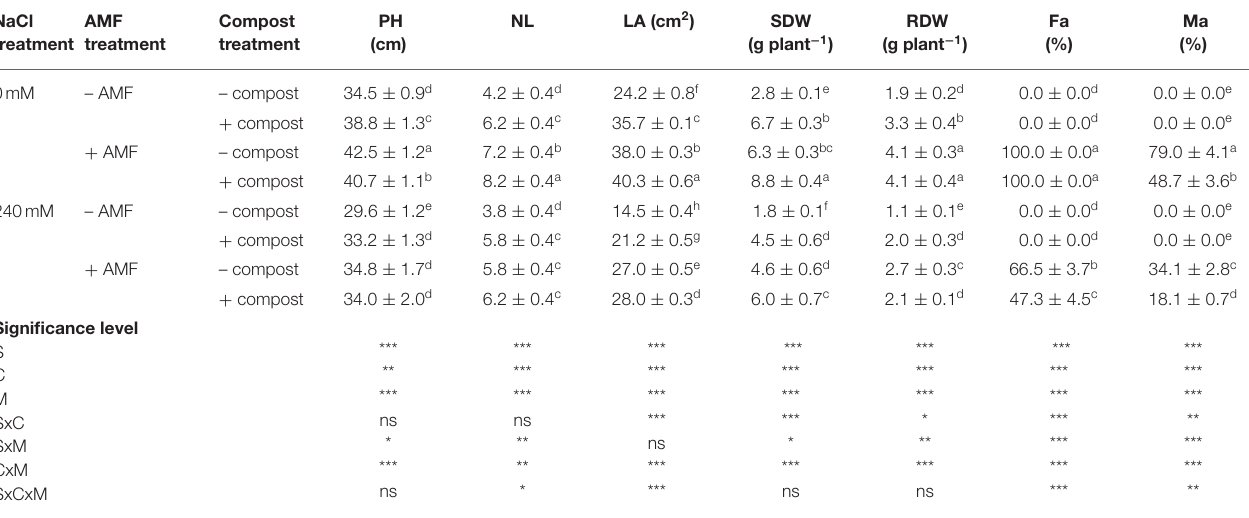
TABLE 1 | Growth traits and AMF infection of date palm plants under saline and non-saline conditions after application of compost and AMF alone or in combination. NaCl AMF treatment